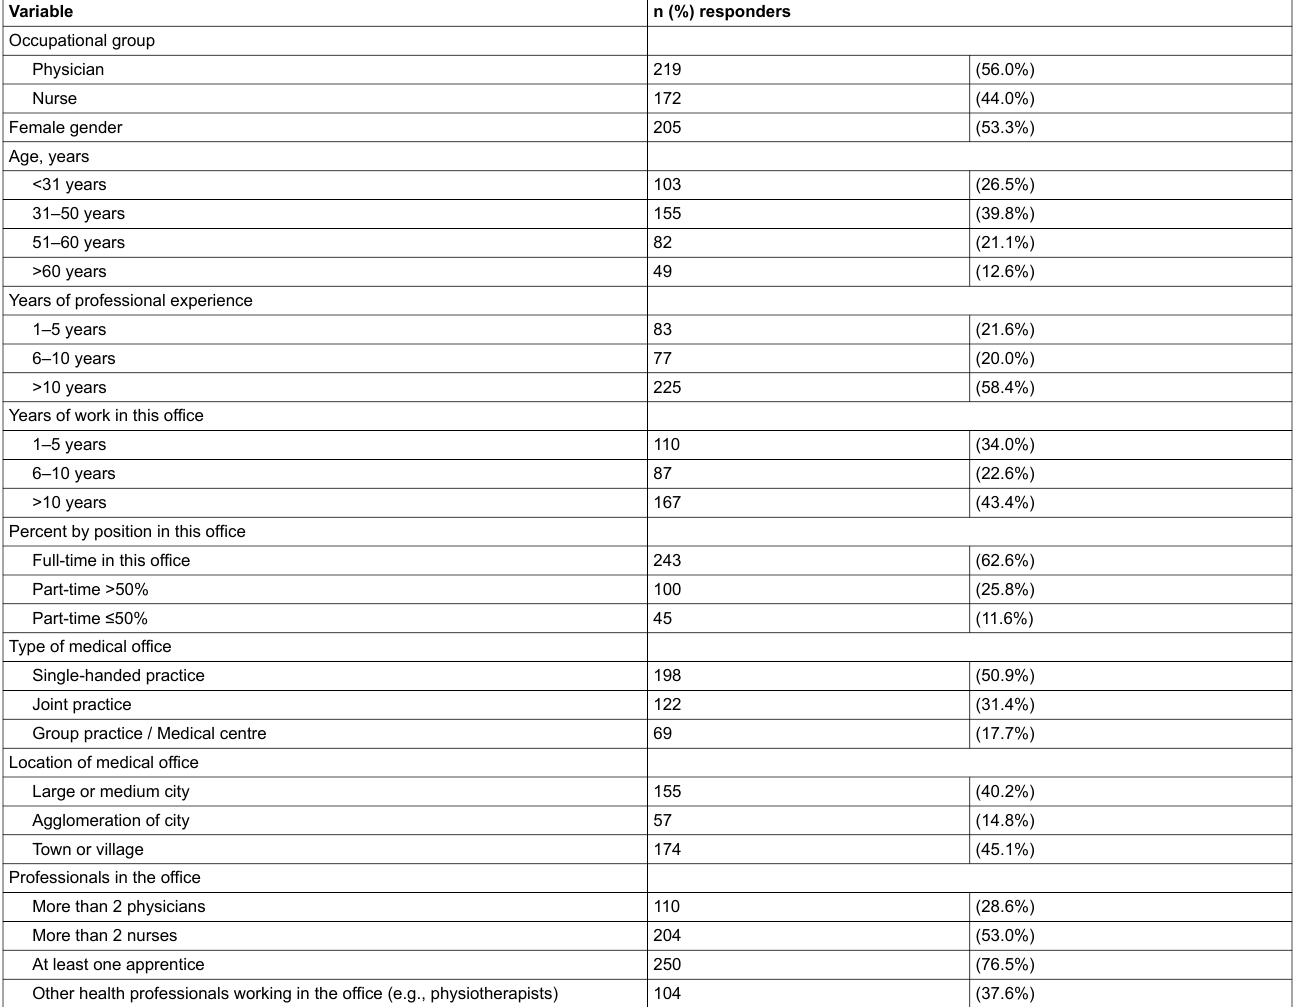
Table 1: Characteristics of responders that described threats to patient safety (n = 391 responders). Variable n (%)